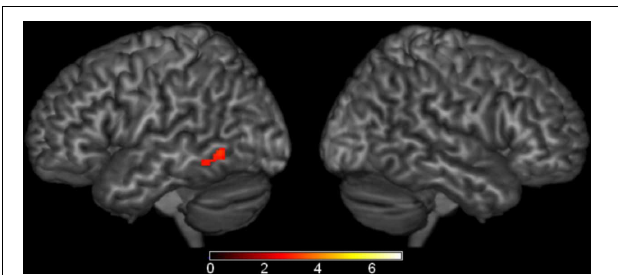
FIGURE 5 | Brain Activations: Semantic > Phonological. Areas in red represent the significant voxels within the left middle temporal gyrus region-of-interest where the semantic conditions elicited greater activation than the phonological condition. Activations are scaled in terms of significant Z -values, corrected p < 0 .